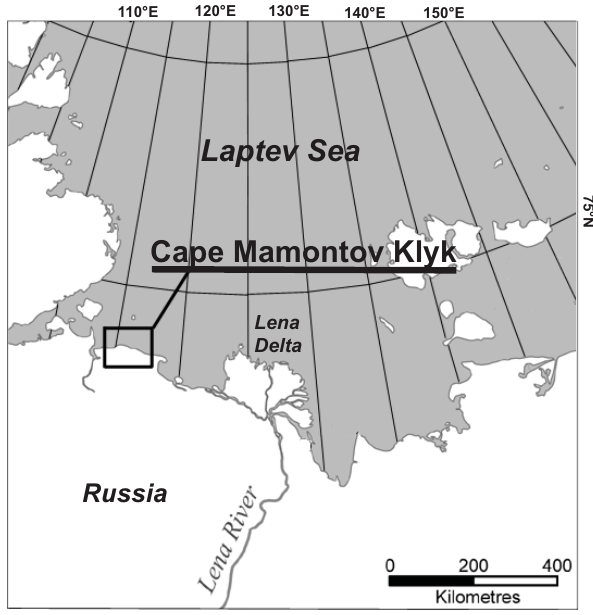
Fig. 1. Location of the Cape Mamontov Klyk sampling site in Arctic Siberia. The studied ice wedges were exposed on a coastal cliff on the Laptev Sea